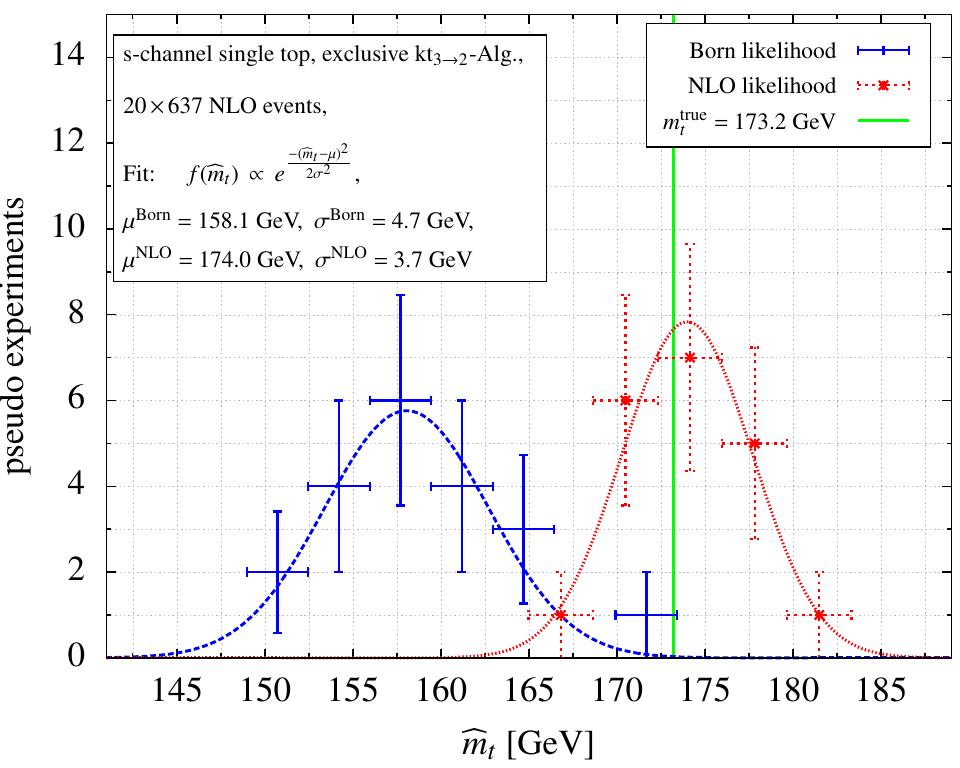
Figure 14 . Distribution of the extracted top-quark mass from exclusive s -channel single top-quark events employing NLO (red, dashed) and Born (blue,solid)